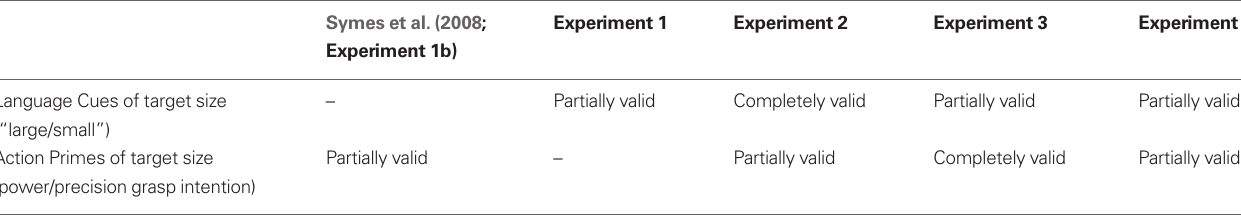
Table 1 | Summary details of Language Cue and Action Prime conditions across